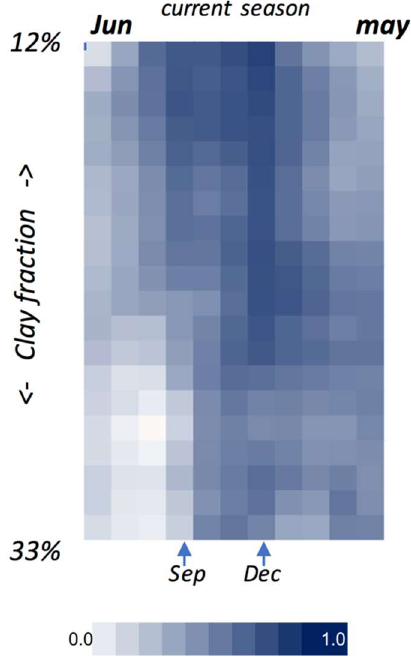
Figure 4. Contingency table of the correlation strength between the yearly cumulated FAPAR vs the monthly FAPAR values from the start up to the end of the growing season at all sites (60) over the 2000–2014 (15), grouped and ordered by clay fraction. The color scale represents the range of the Pearson correlation coefficient values, with white representing null values and blue positive values.